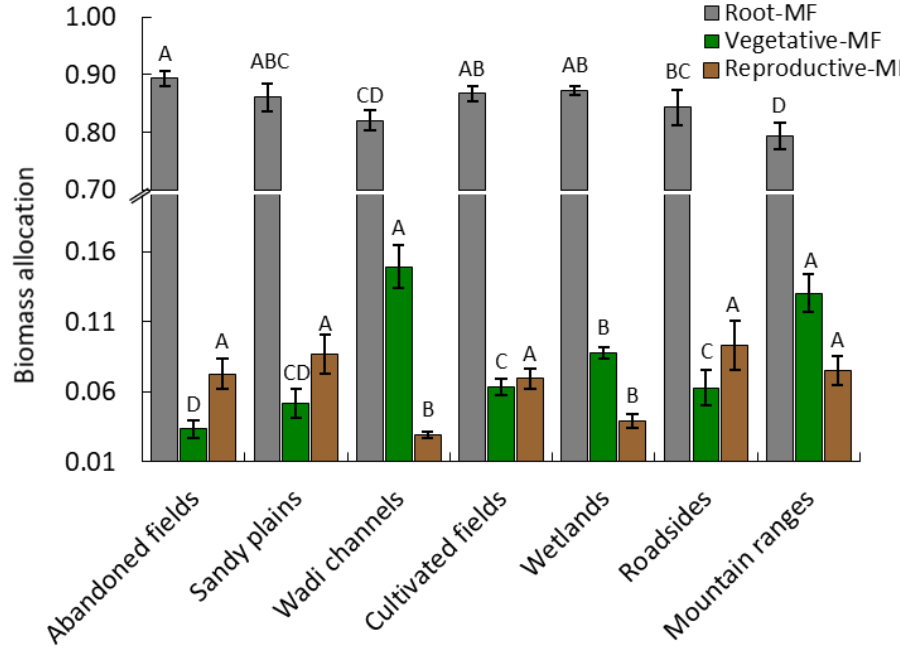
Figure 2. Biomass allocation of root, vegetative, and reproductive mass fraction (MF) based on the dry matter (g) of Argemone ochroleuca within the di ff erent habitats. Values are means ( n = 10) and the bars represent the standard deviation. Within each parameter, values with the same letter are not significantly di ff erent at the 0.05 level using Tukey’s test.